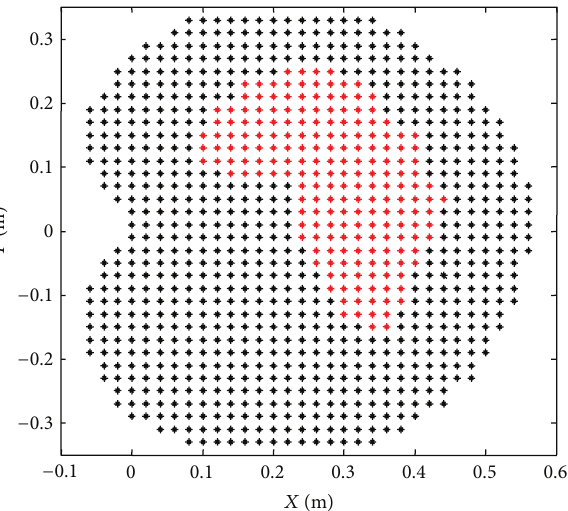
Figure 19: Attainable space and mission attitude